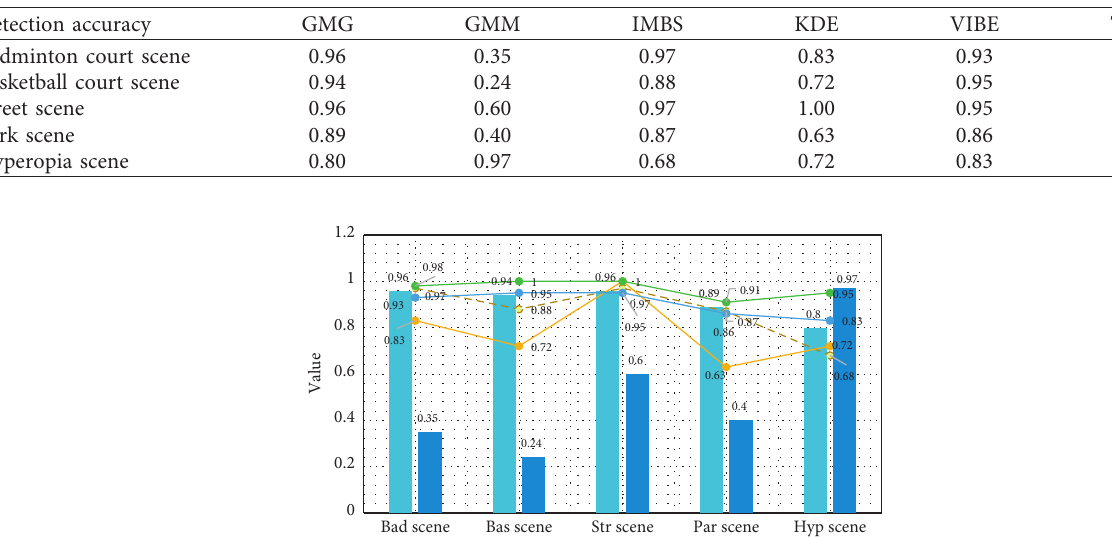
Table 5: Data of accuracy index for dynamic background video library scene detection.